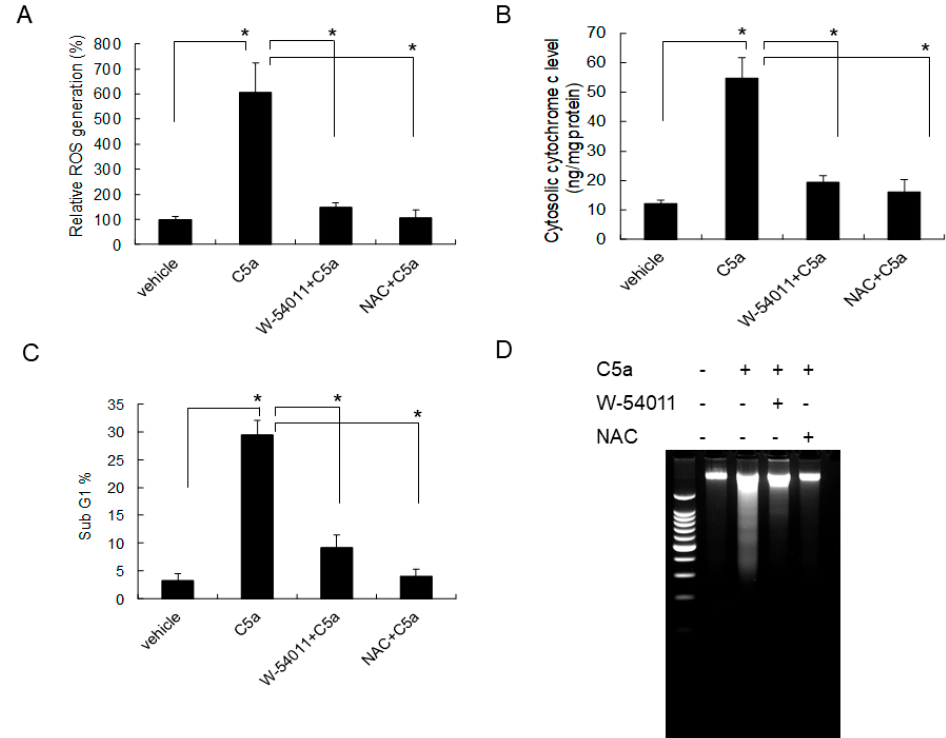
Figure5. Figure 5. C5aR inhibitors (W-54011) or N-acetylcysteine (NAC) rescued high-dose C5a treatment- induced ROS formation and apoptosis in mouse KECs. ( A ) Mouse KECs were pretreated with the